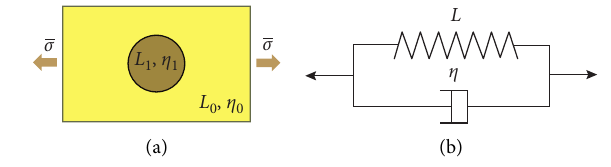
Figure 2: Loading process